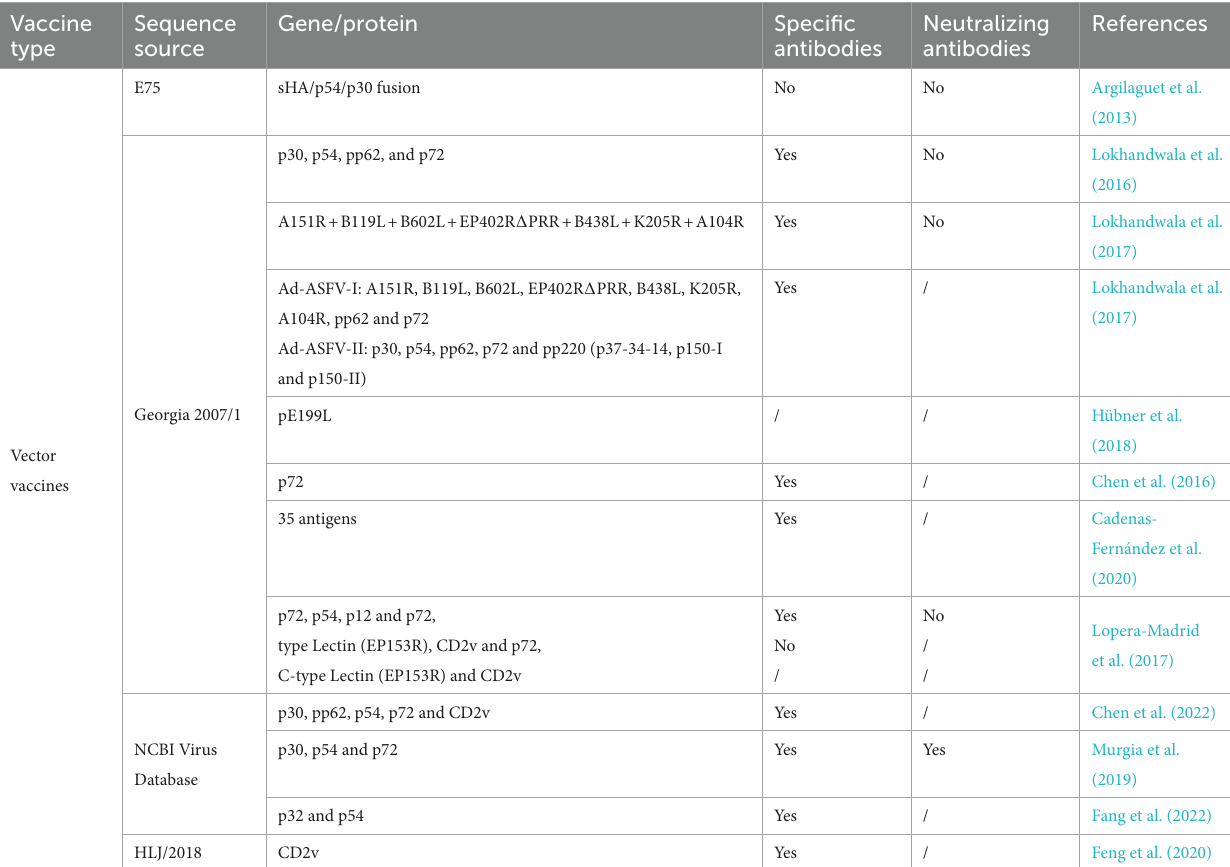
TABLE 5 ASF vector